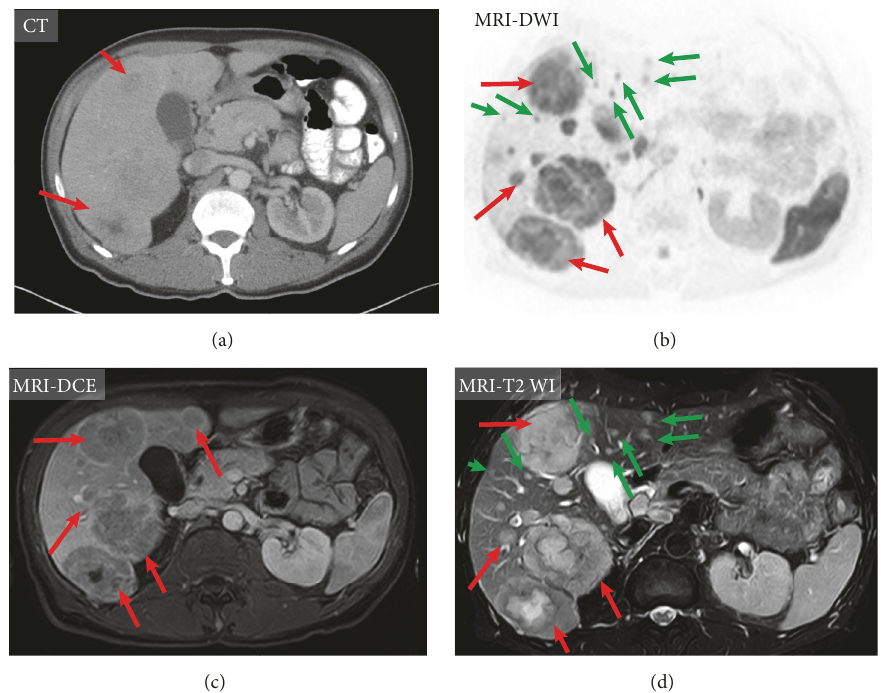
Figure 9: Imaging of hepatic metastases in medullary thyroid carcinoma of the same patient using contrast-enhancedcomputed tomography (CT) (a), magnetic resonance imaging (MRI), diffusion-weighted sequence (b); contrast-enhancedMRI, T1 weighted images (DCE)(c); MRI, T2 weighted image (d). MRI shows improved visualization of metastatic lesions compared to CT (red arrows) and can also detect very small metastases (green arrows), which may not be visible on